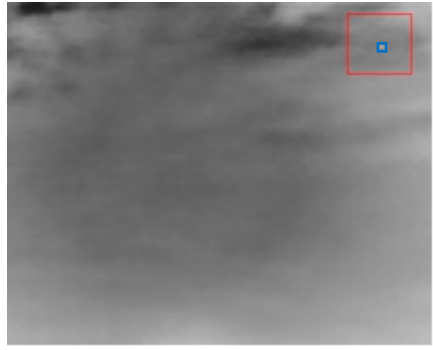
Figure 5. The neighborhood area of the target.